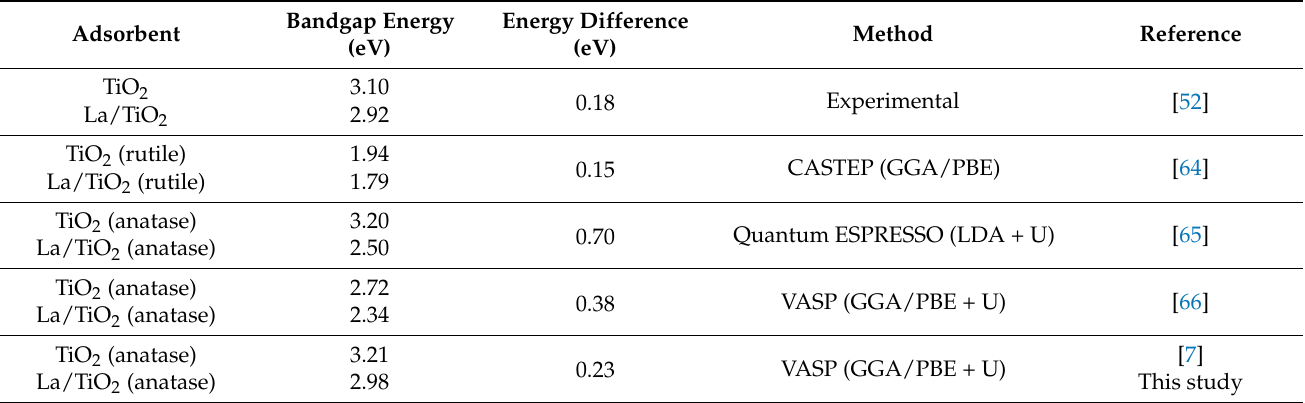
Table 4. Bandgap energy differences (eV) between TiO 2 and La/TiO 2